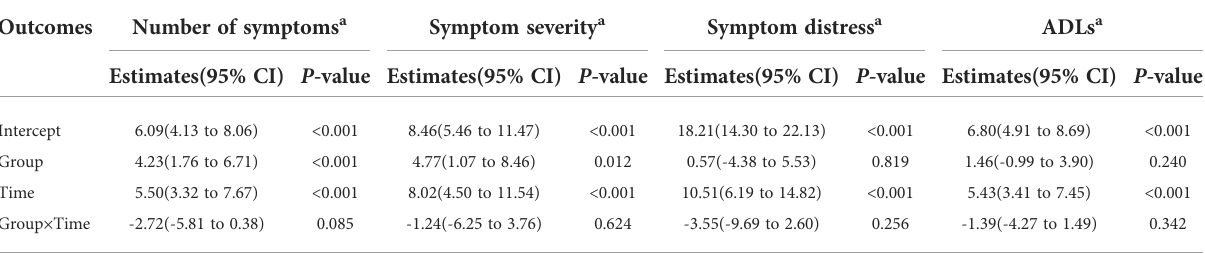
TABLE 4 Results of the generalized linear mixed-effects models for symptom experience and